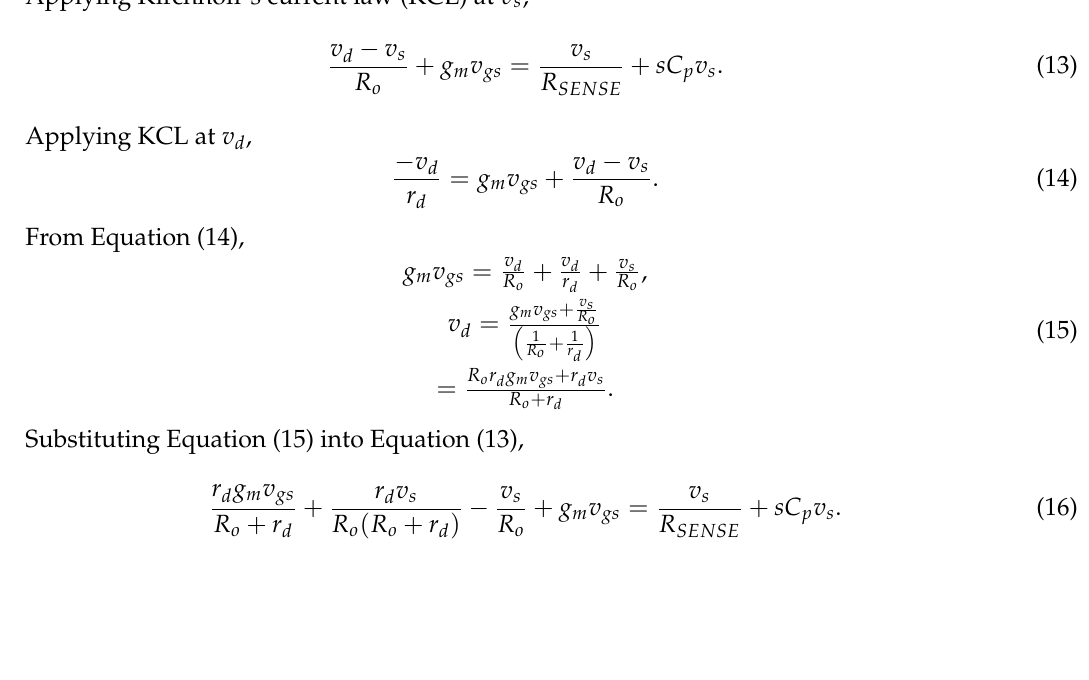
Figure 8. Small signal equivalent circuit of the GaN field effect transistor (FET) common drain stage. The GaN LED was modelled as a voltage source with a series resistance of r d . r d that can be estimated from the slope of the I–V curve of the GaN LED in the forward biased region.